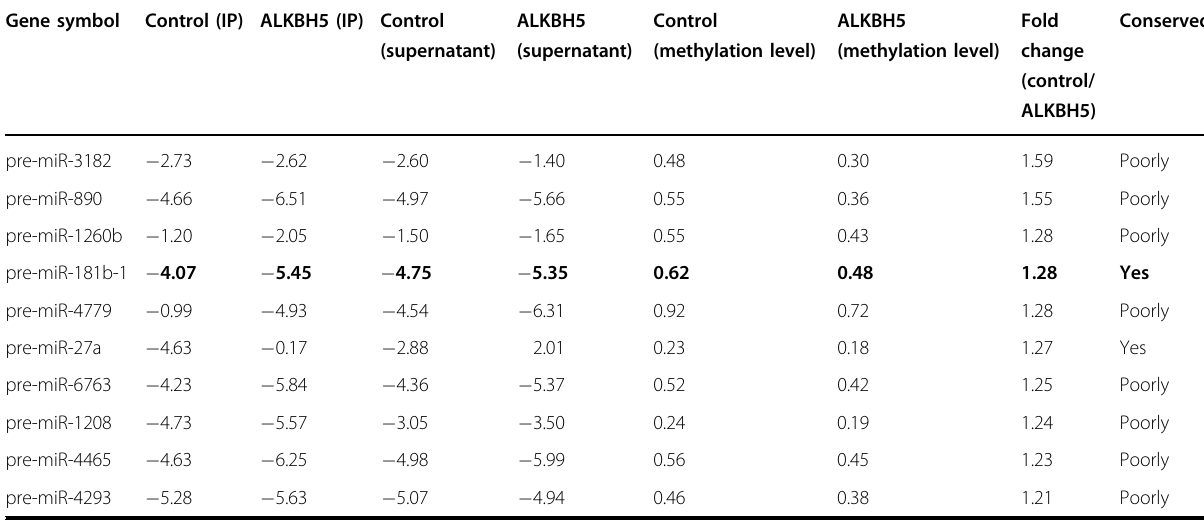
Table 1 Top 10 pre-miRNAs with ALKBH5-mediated m 6 A demethylation. Gene